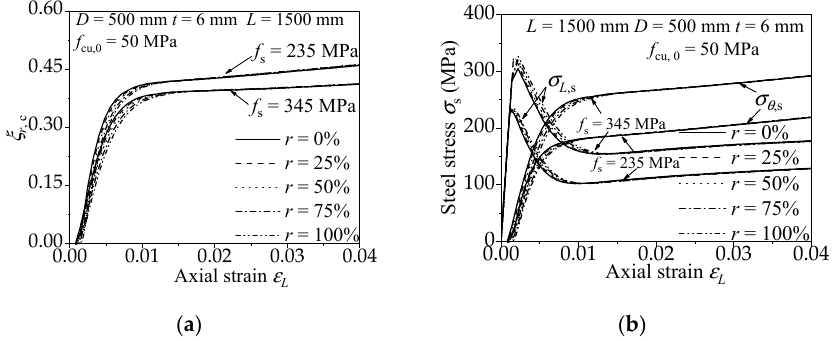
Figure 8. Effect of steel strength on confinement effect of RACFCST stub columns: ( a ) radial stress– axial strain curves; ( b ) ξ r, c –axial strain curves.